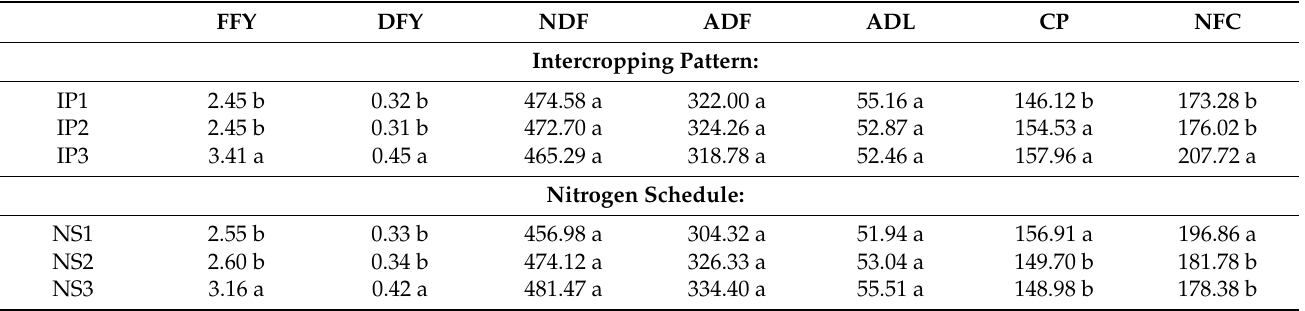
Table 6. Variations of the 2nd cut fresh and dry forage yields (t ha − 1 ), neutral detergent fiber (NDF), acid detergent fiber (ADF) and acid detergent lignin (ADL), crude protein (CP), and non-fiber carbohydrates (NFC) contents (g kg − 1 ) of forage cowpea as affected by the intercropping pattern and nitrogen schedule combined over the two growing seasons.